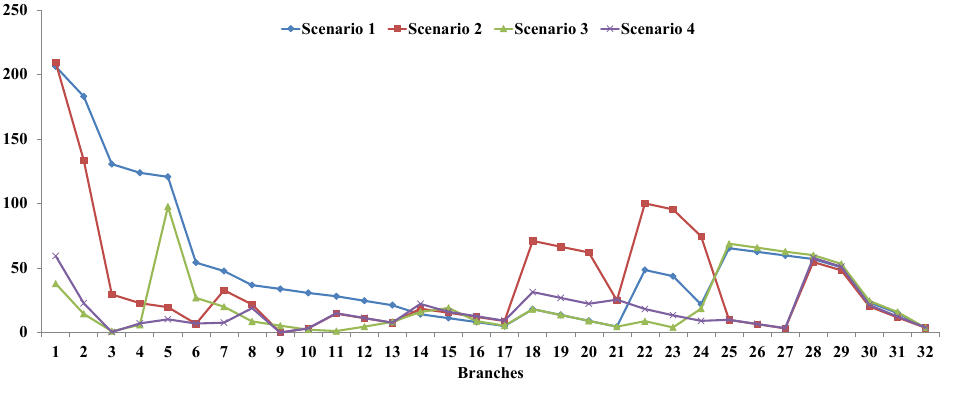
Figure 8. Current profile of the network with different scenarios.